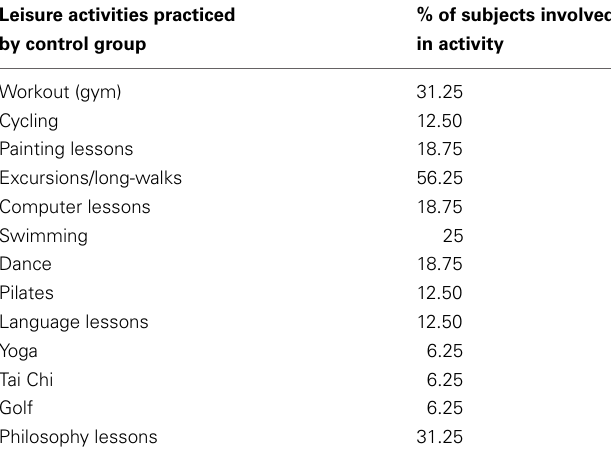
Table 1 | Summary of leisure activities practiced by the control